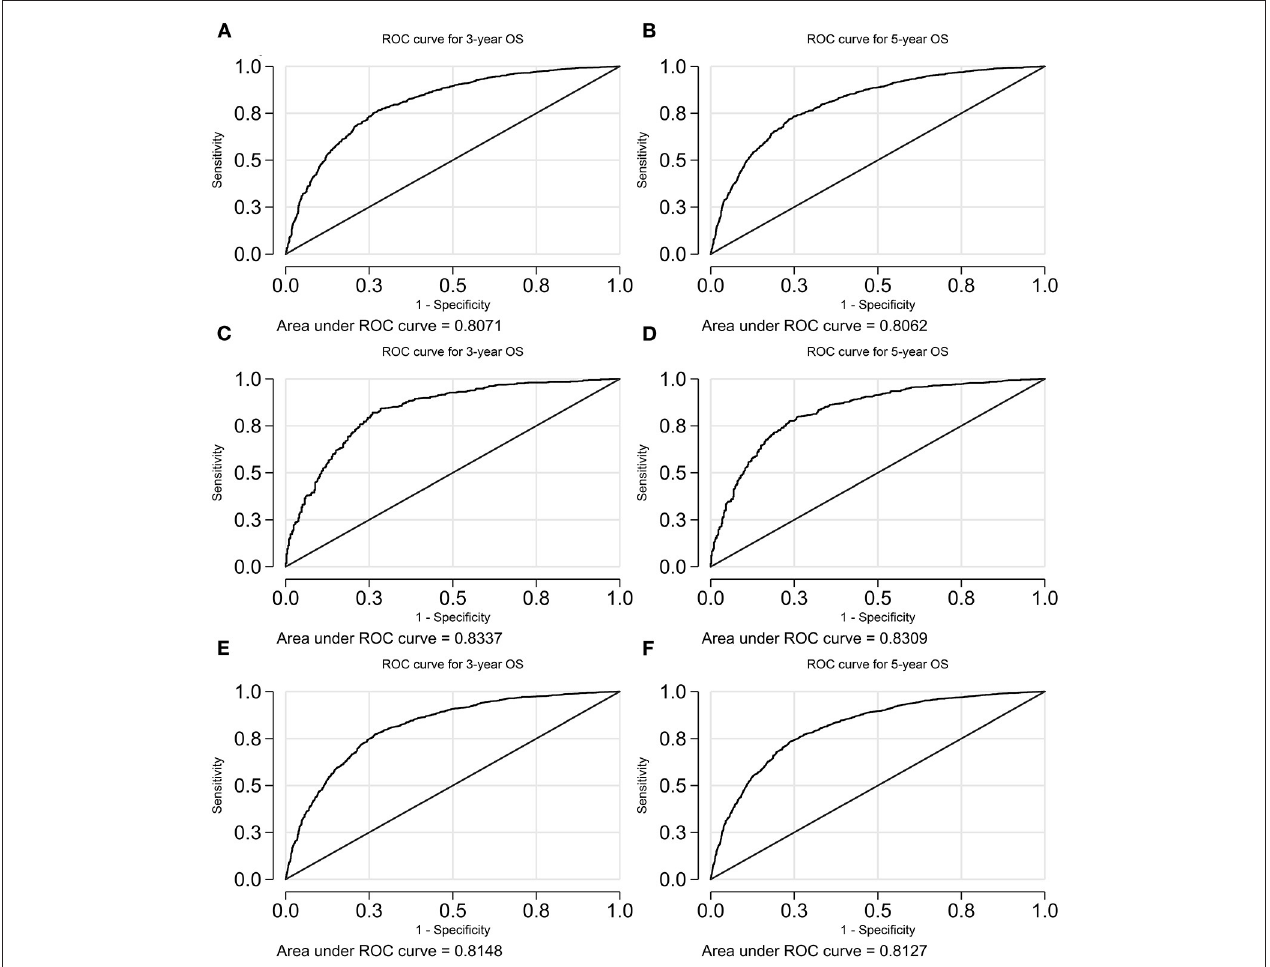
FIGURE 6 | A receiver operating characteristic (ROC) curve of the model predicting OS. (A) 3-years OS in the training cohort; (B) 5-years OS in the training cohort; (C) 3-years OS in the validation cohort; (D) 5-years OS in the validation cohort; (E) 3-years OS in the overall cohort; and (F) 5-years OS in the overall cohort. OS, overall